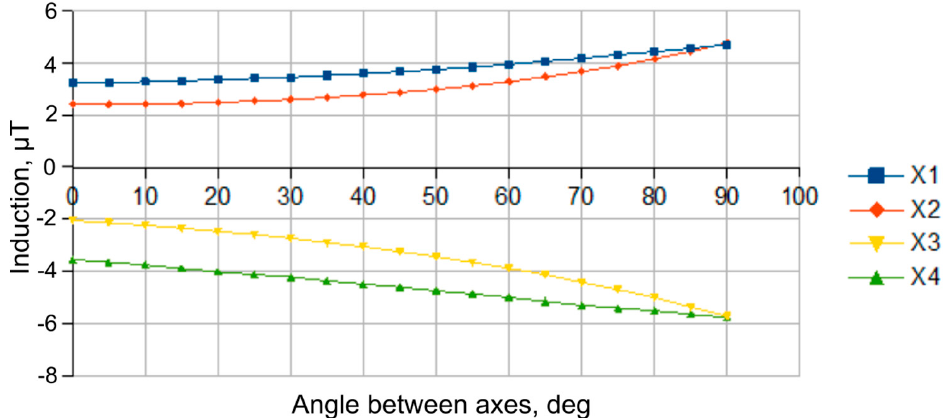
Figure 10. Dependence of the magnetic induction vector component along the X-axis in ferroprobe cores ("X1" − "X4" curves correspond to "D1" − "D4" sensors) with the shield longitudinal axis and power cable axis arranged in the same plane.